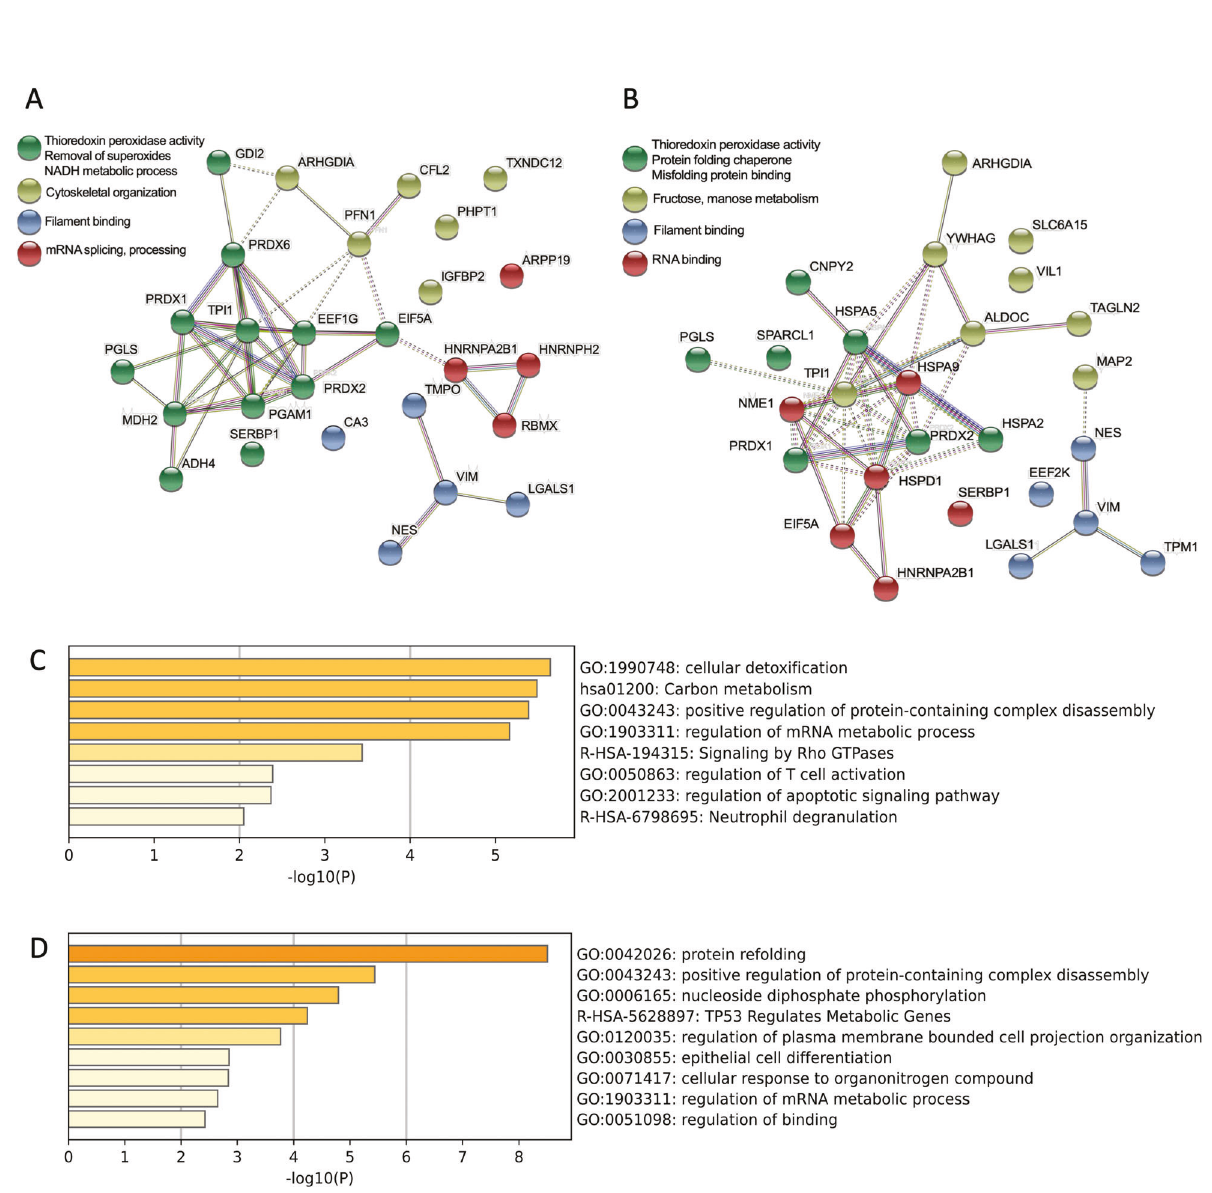
Fig. 3 Protein pathway maps. Interaction maps of CM-containing proteins between 10 and 50 kDa visualized with STRING program ( A ) and their associated gene ontology signaling pathways, generated with Metascape ( C ). Protein interaction maps of CM-containing proteins following heating at 60 °C, generated with STRING program ( B ) and their associated pathways generated with Metascape ( D ).